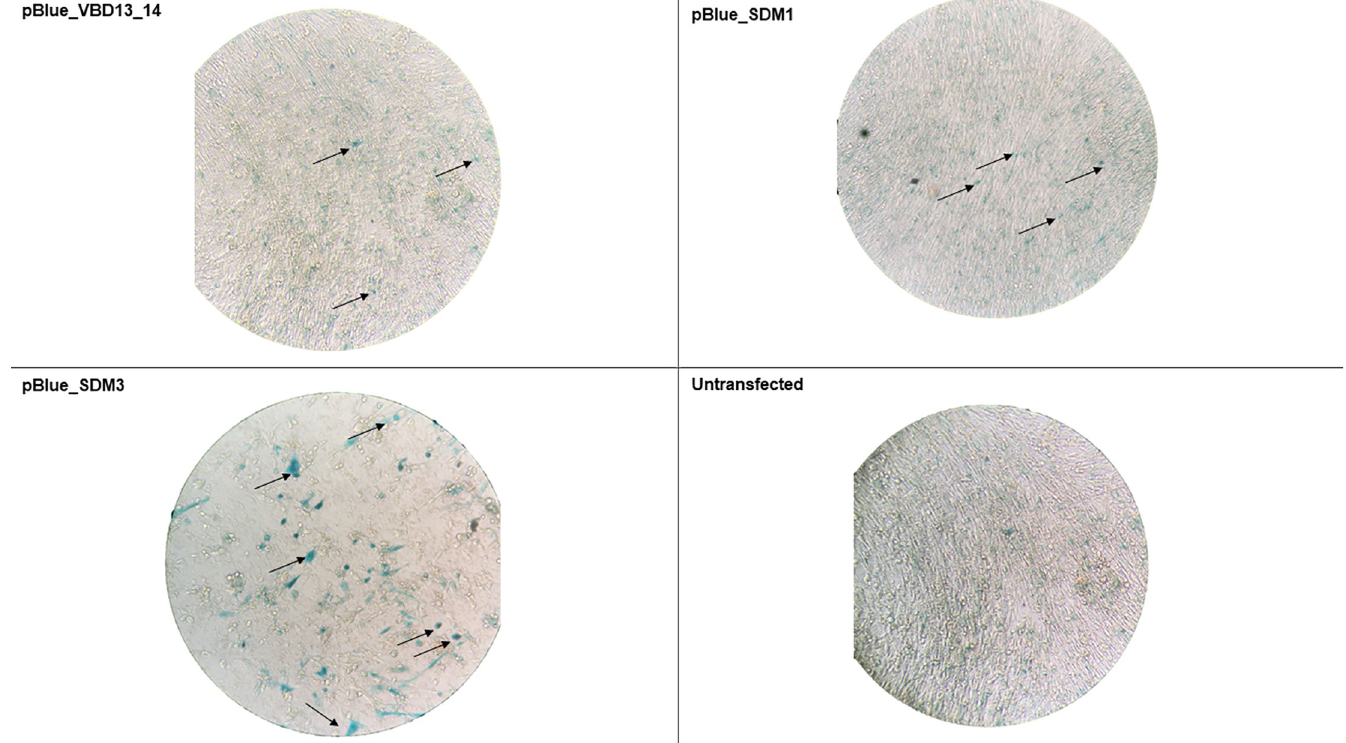
Fig 3. β -galactosidase staining for determination of transfection efficiency of transfected BHK cells. BHK cells transfected with pBlueVBD13_14, pBlue_SDM1 and pBlue_SDM3 and stained for β -galactosidase. Untransfected BHK cells with slight staining that shows endogenous β -galactosidase activity. Black arrows indicate some of the stained transfected BHK cells per